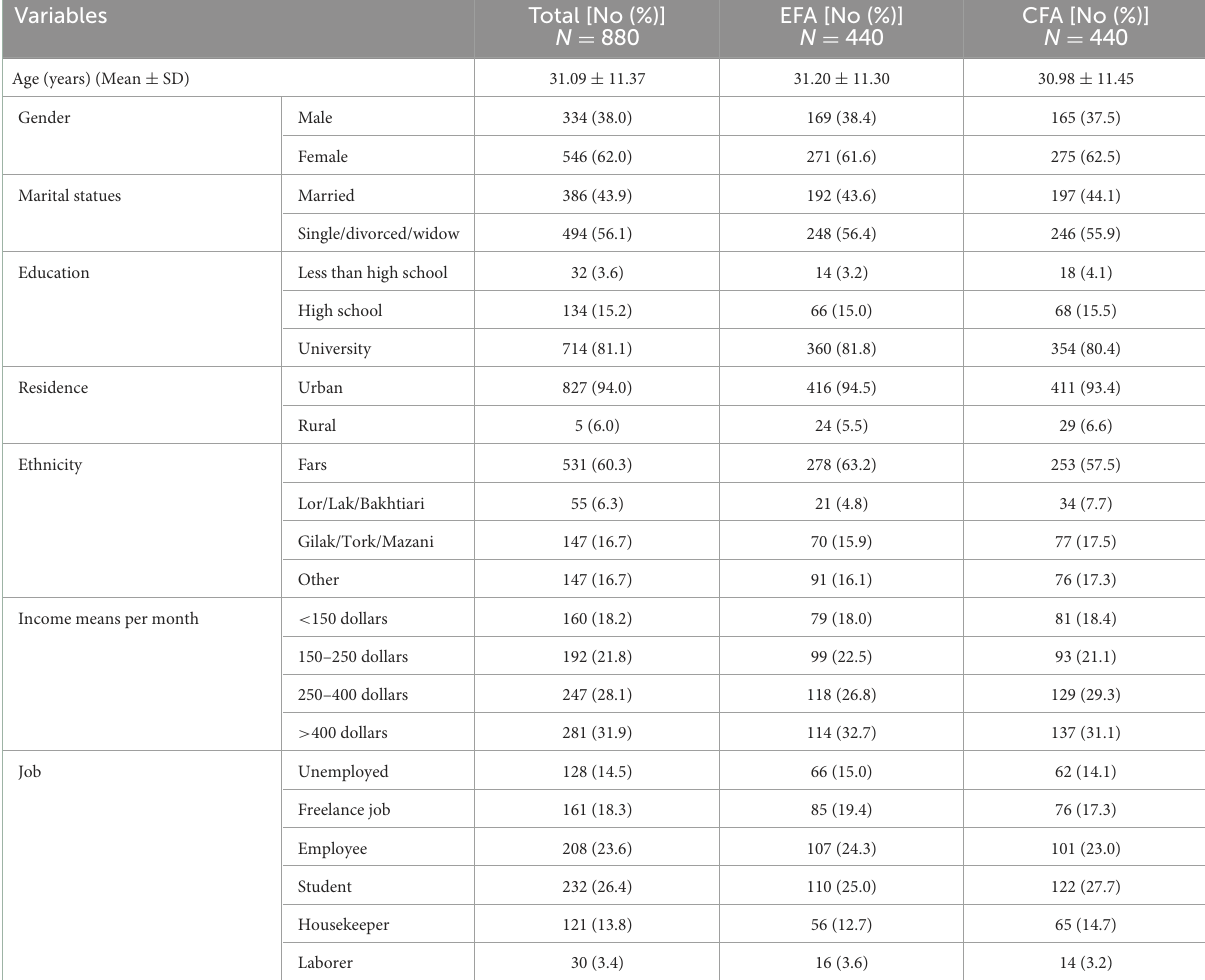
TABLE 1 Participant characteristics in the study in two exploratory (EFA) and confirmatory factor analysis (CFA) ( n = 880).